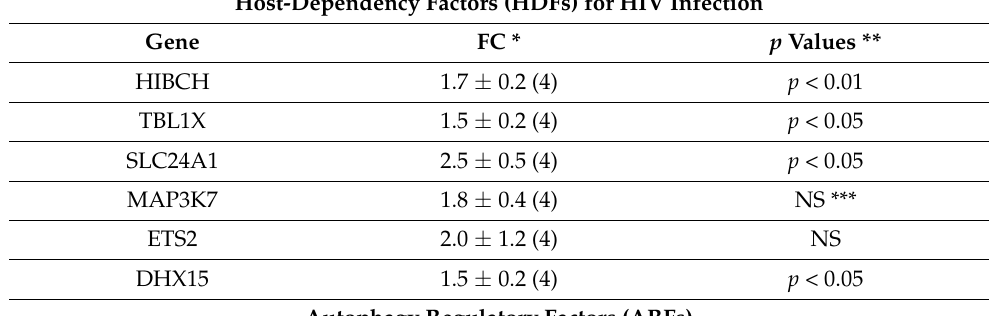
Table 3. Expression levels of HDF and ARF in miRAB40-transfeced cells. Host-Dependency Factors (HDFs) for HIV